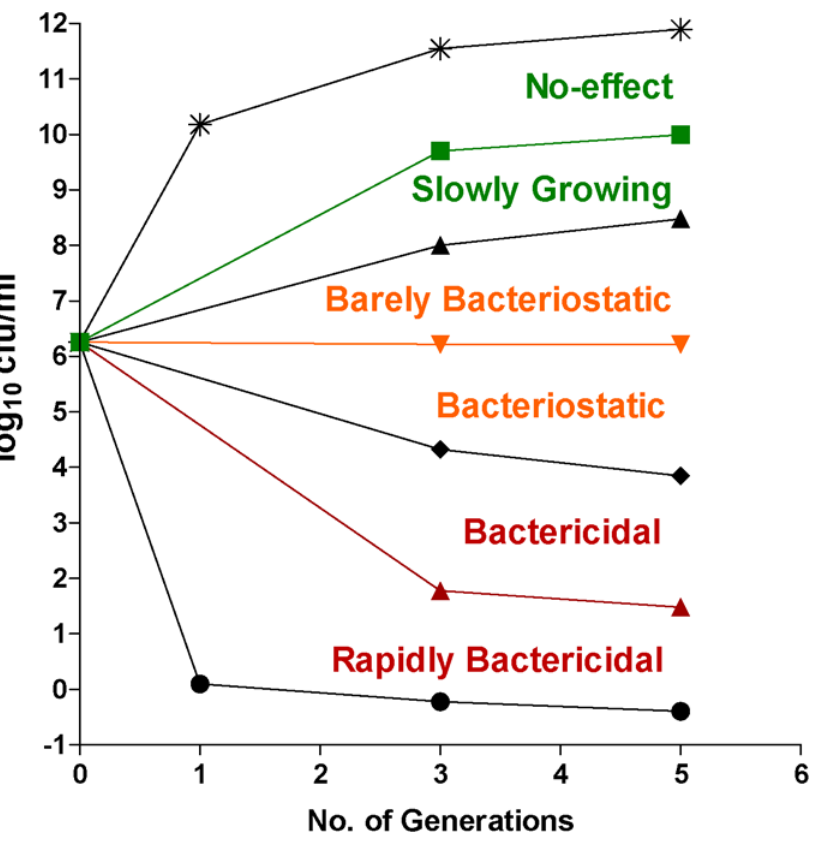
Figure 5. Bacteriostatic and bactericidal target zones. Generic survival kinetics on delineating bactericidal and bacteriostatic targets. The zones differentiating cidality, stasis and no effect are indicated.